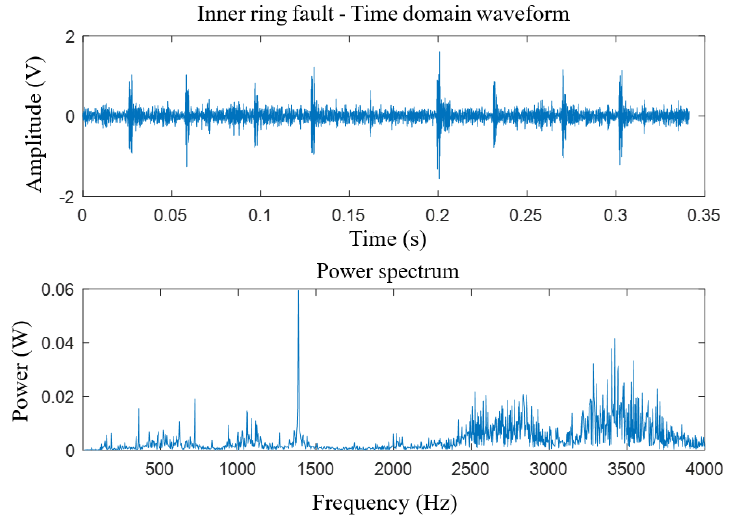
Figure 13. The power spectrum of inner ring fault signal.